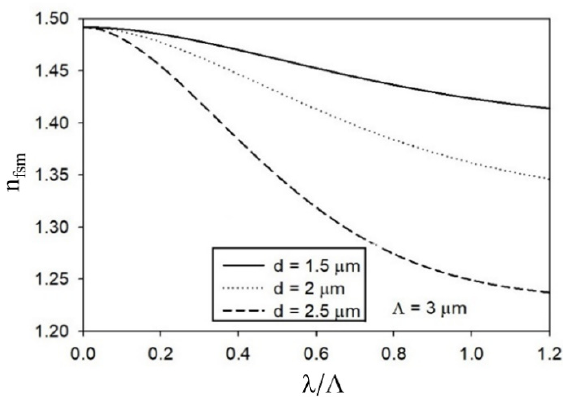
Λ . n as a function of / λ Λ . Figure 2. Effective RI of the inner cladding n fsm as a function of λ / fsm